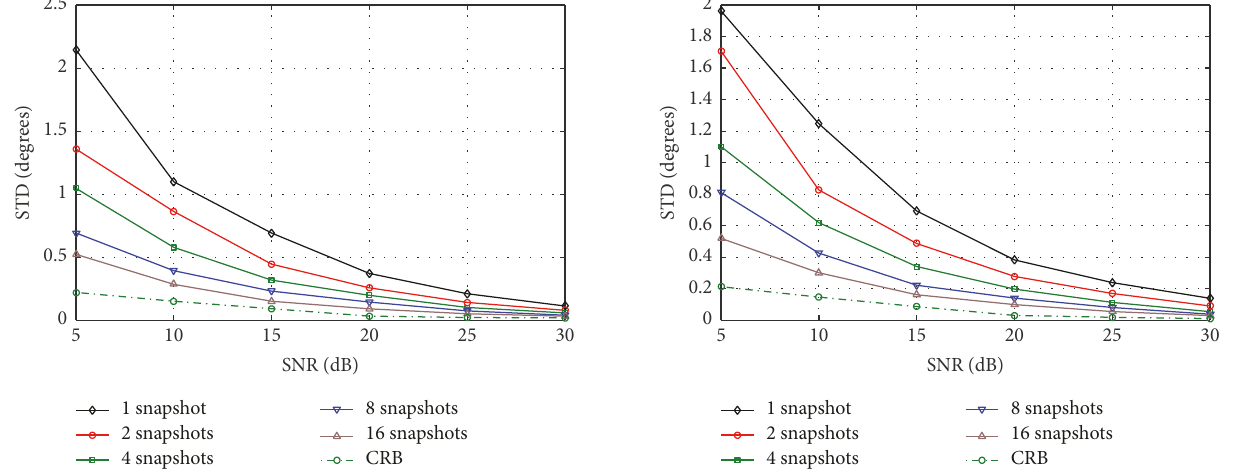
Figure4:StandarddeviationversusSNRforsource2(noncoherent) located at (𝜃 2 = 80 ∘ ,𝜙 2 = 60 ∘ ) for the proposed method.